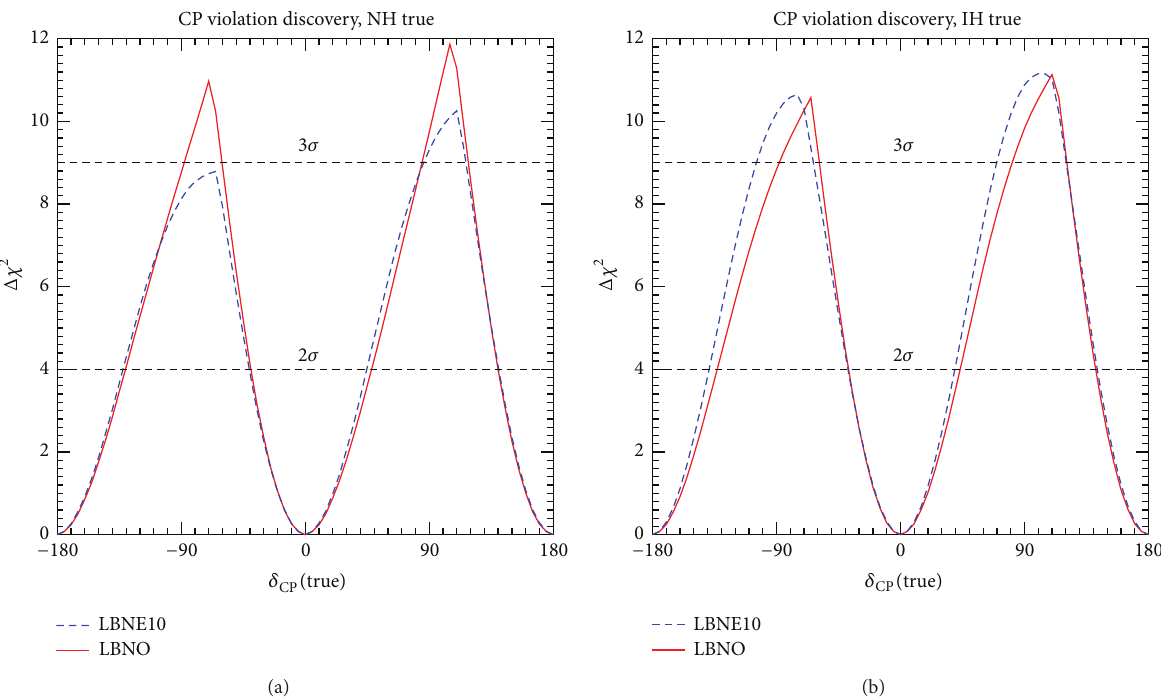
Figure 16: Left panel (right panel) shows the Δ𝜒 2 for the CP violation discovery as a function of true value of 𝛿